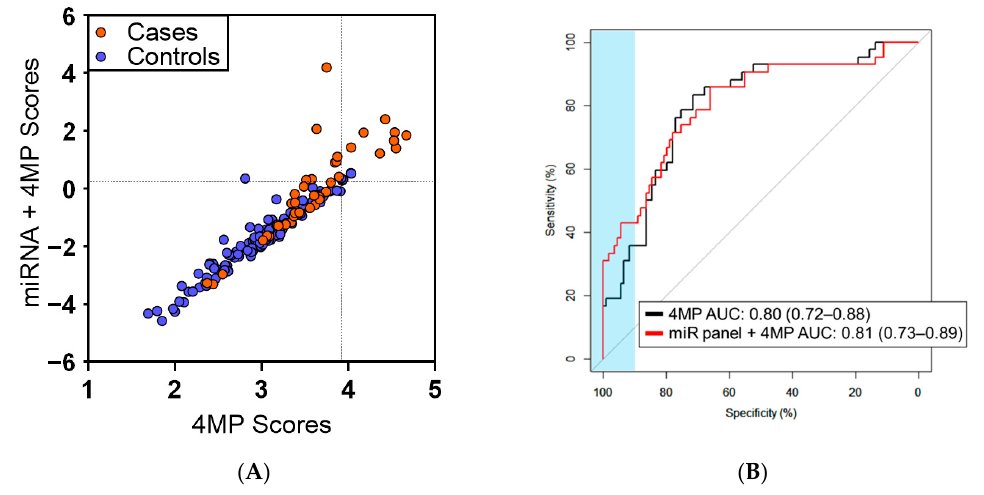
Figure 2. Predictive performance as indicated by area under the curve (AUC) for 3-marker miRNA panel miRNAs in lung cancer prediagnostic serum validation cohort.